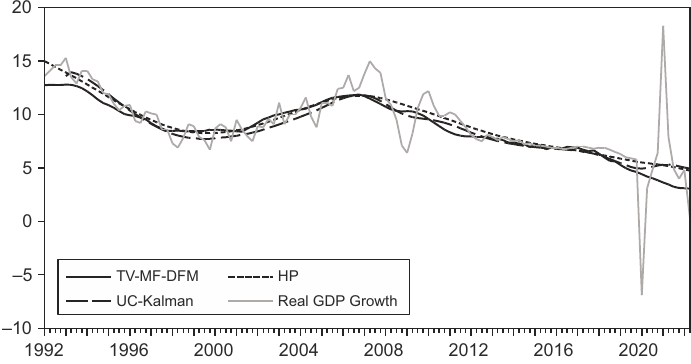
Figure 2. Characteristics of the trend estimated by three